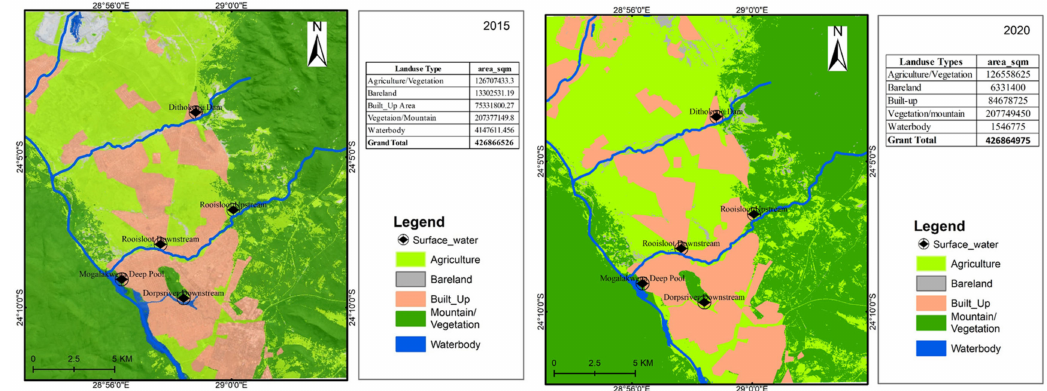
Figure 6. Land-use map of the study area for year 2015 and 2020.